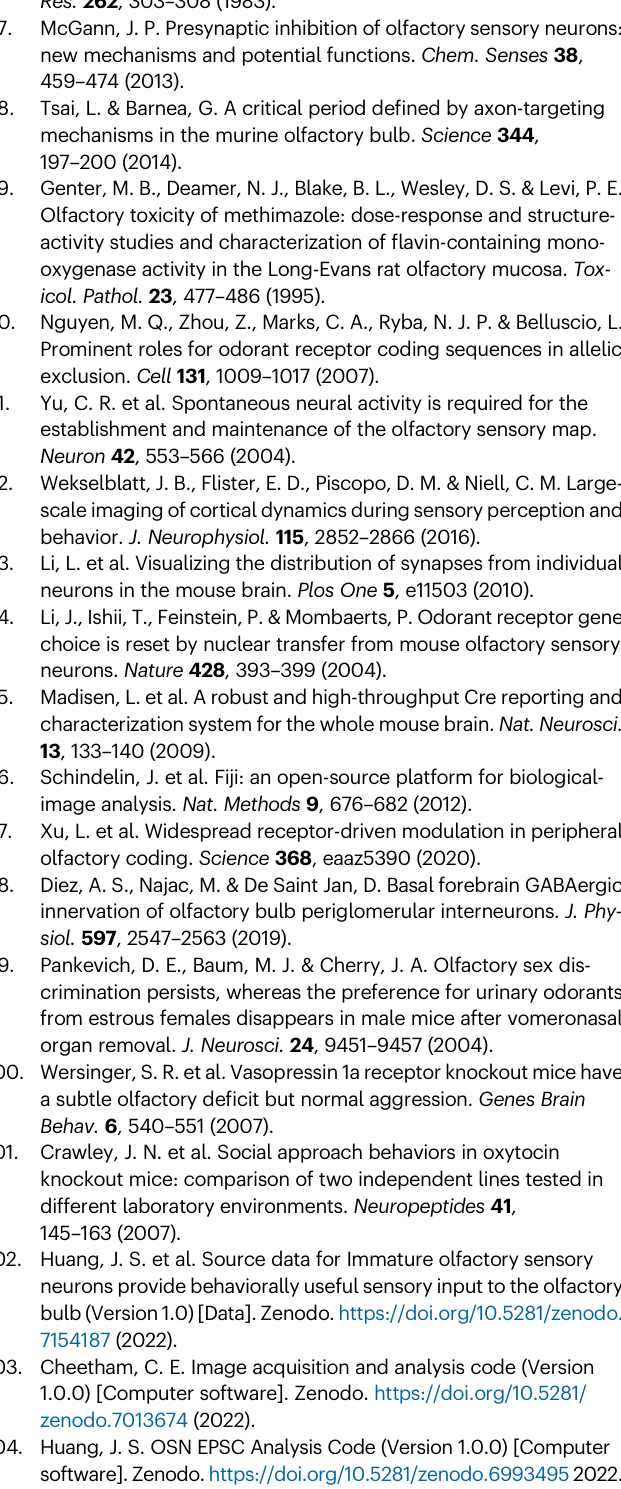
knockout mice: comparison of two independent lines tested